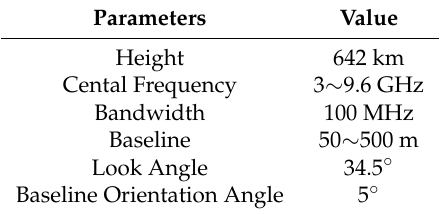
Table 1. Parameters of multibaseline interferometric synthetic aperture radar (InSAR) simulation system.